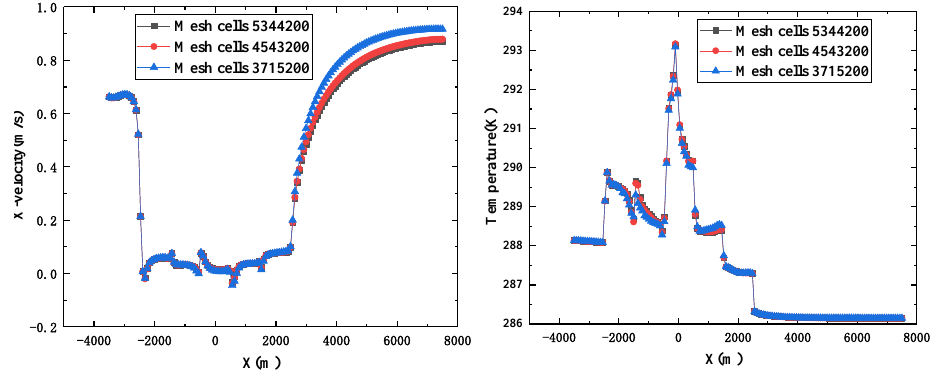
Figure 3. Grid independence test results.